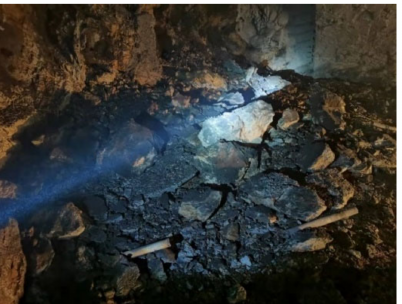
Figure 13. The distribution of rock blocks after rock mass cracking in the test